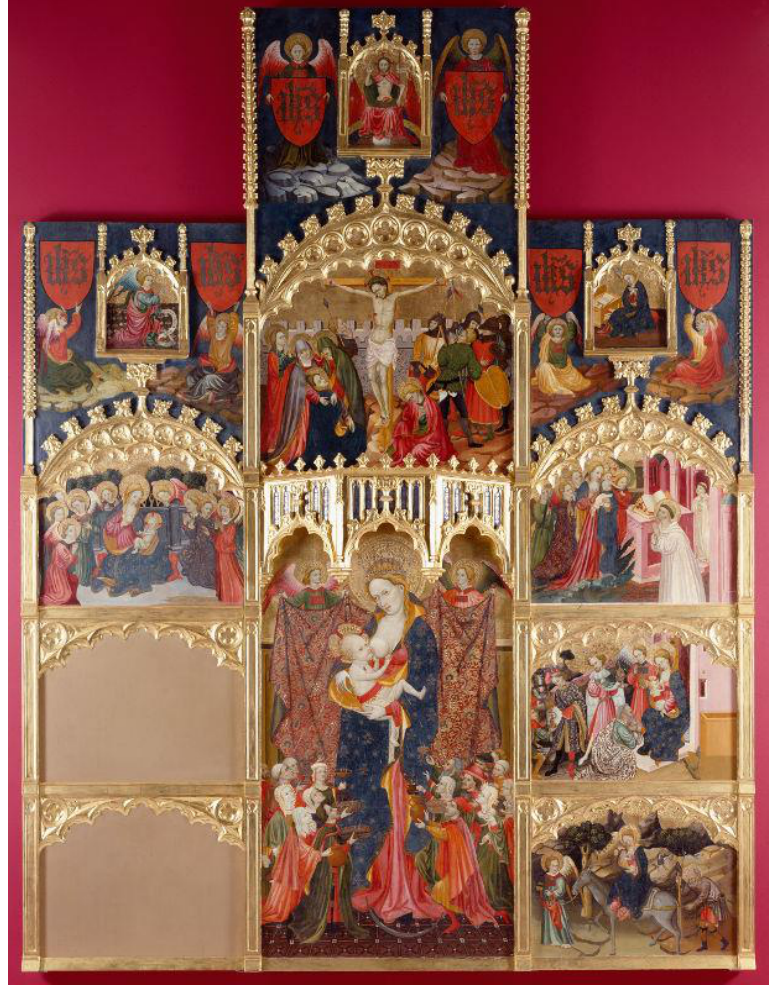
Figure 4. Antoni Peris. Retaule de la Mare de Déu de la Llet . © Museu de Belles Arts de València.